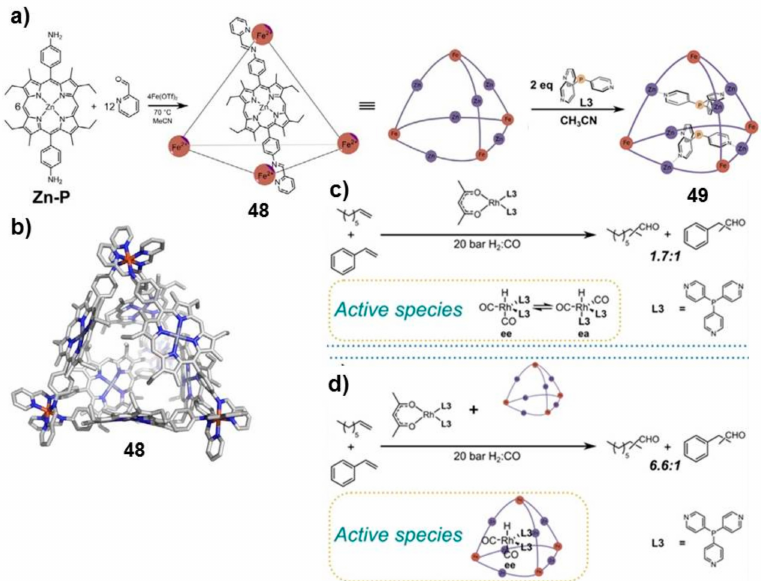
Figure 9. ( a ) Formation of the tetrahedral cage 48 ; ( b ) optimized structure of cage 48 ; ( c ) formation of the complex between 48 and two trispyridylphosphine ligands, leading to nanocage 49 ; ( d )hydroformylationofalkenesinsolutionbyafreerhodiumphosphinecatalyst; ( e )hydroformylationof alkenes by an encapsulated rhodium phosphine catalyst into 48 (adapted from Ref. [47], with permission of John Wiley and